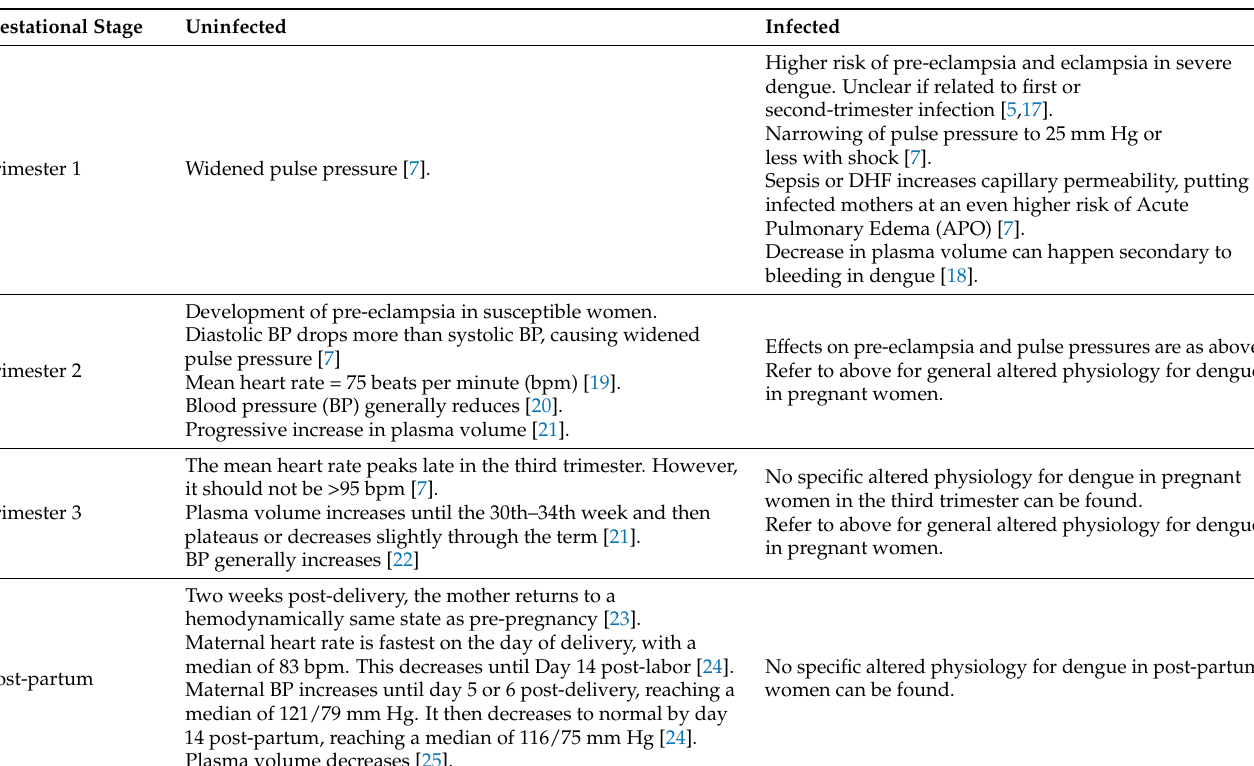
Table 1. Uninfected versus dengue-infected cardiovascular changes in pregnant women.